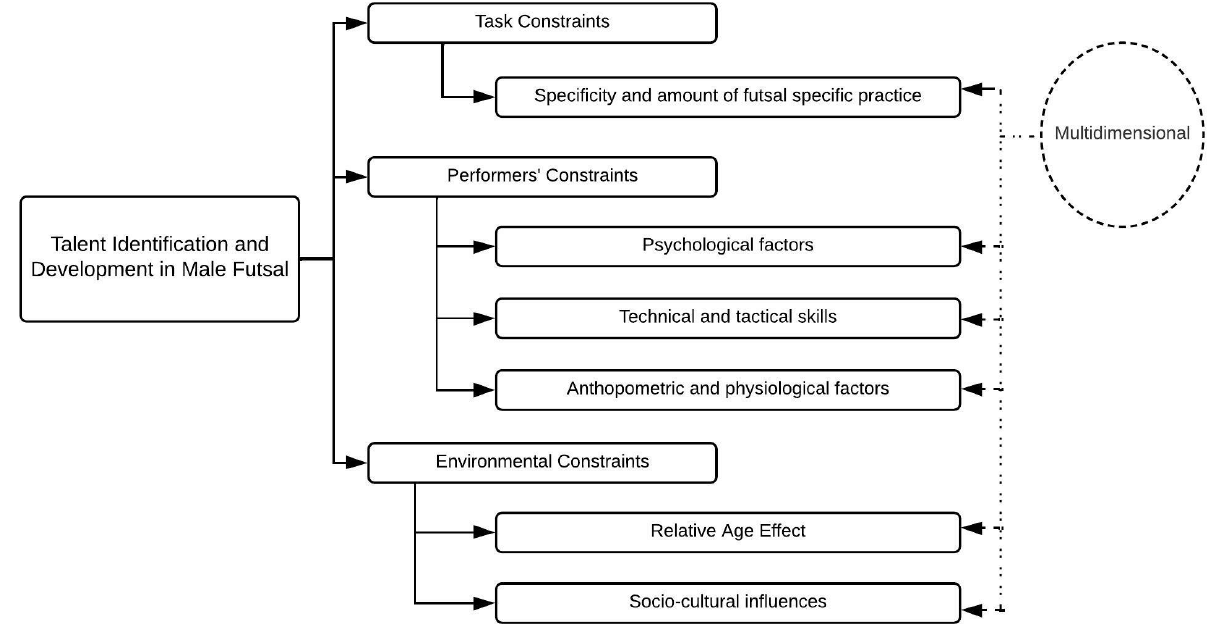
Figure 2. Scopes of talent identification and development in futsal.